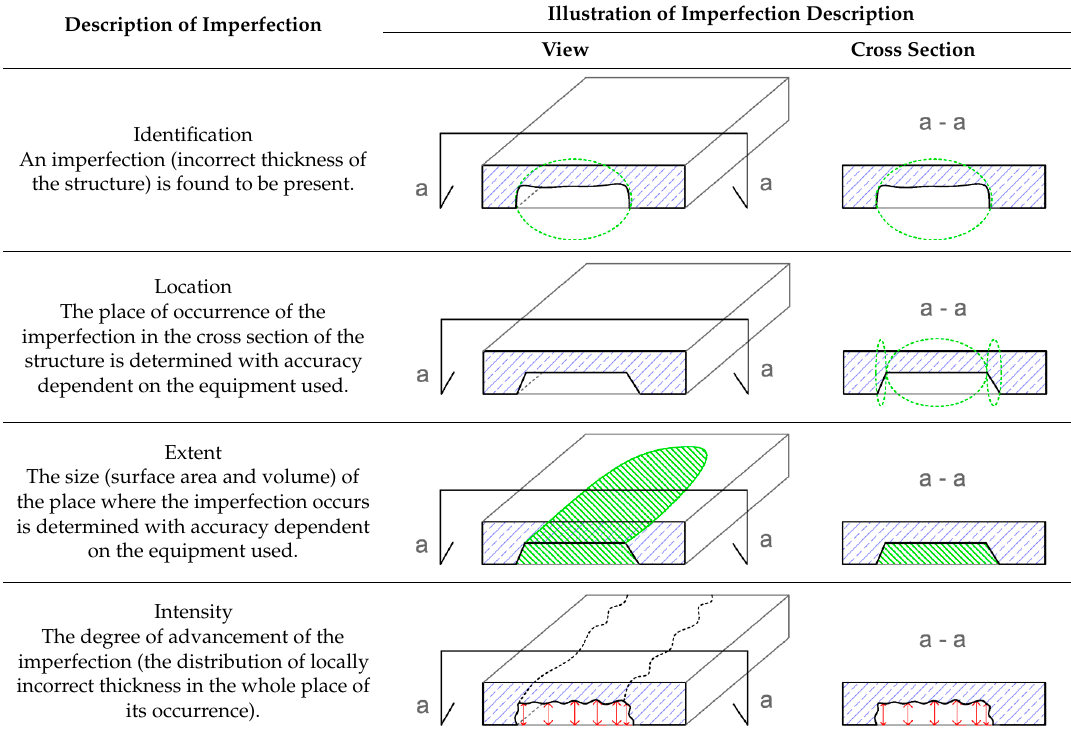
Table 3. Explanation of proposed terms for describing materials imperfection—delamination in concrete structures tested by non-destructive acoustic